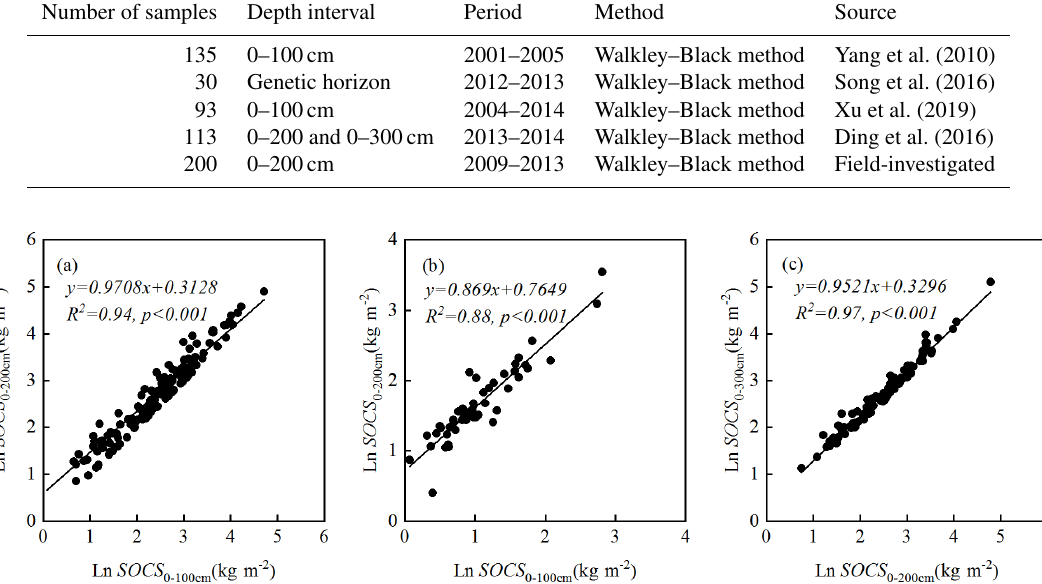
Figure 4. Extrapolation function of the SOCS between soil depth intervals of (a) 0–100 and 0–200cm in grassland ecosystems, (b) 0–100 and 0–200cm in desert ecosystems, and (c) 0–200 and 0–300cm in grassland ecosystems.